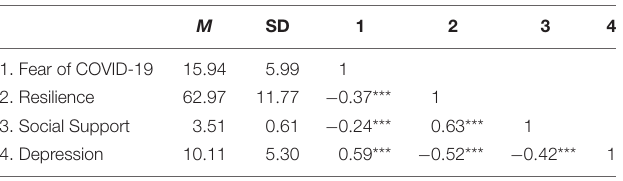
TABLE 2 | Descriptive statistics and correlations between variables ( N =